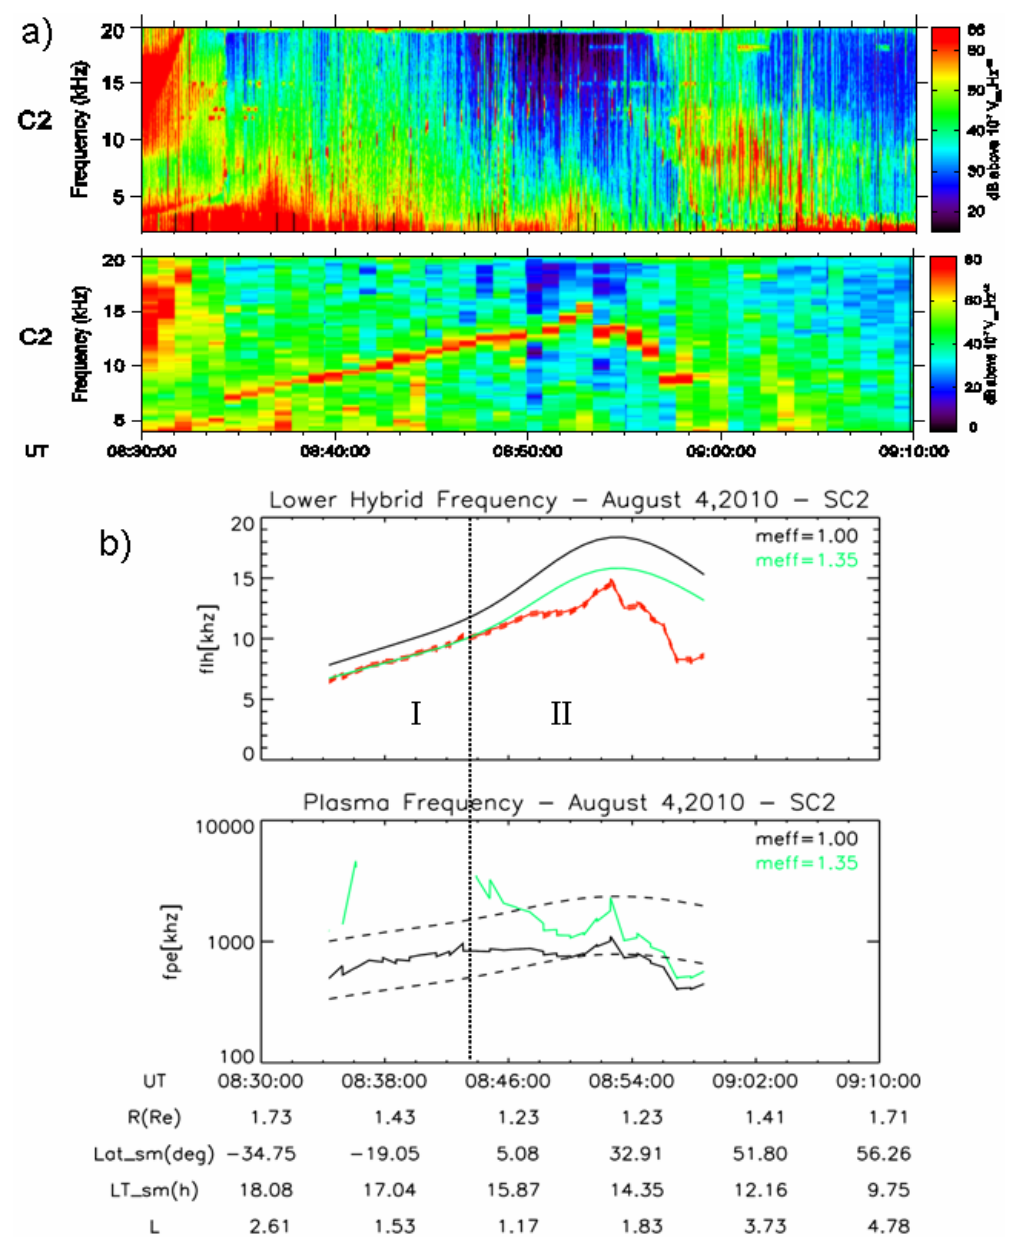
Figure 6. Analysis of F lh measurements on the C2 satellite, for the August 4th, 2010 case event. (a) Frequency time spectrograms from the WHISPER instrument. Top: active and passive spectra. Bottom: active spectra. (b) Same parameters and presentation as panels (b) and (c) in Fig. 5.